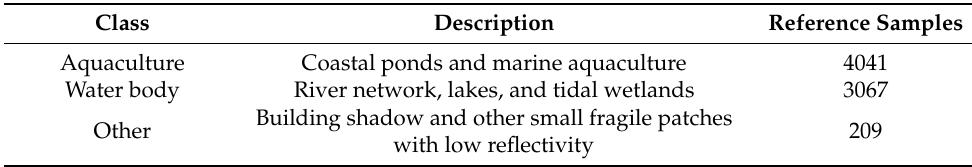
Table 2. Classification system used in this